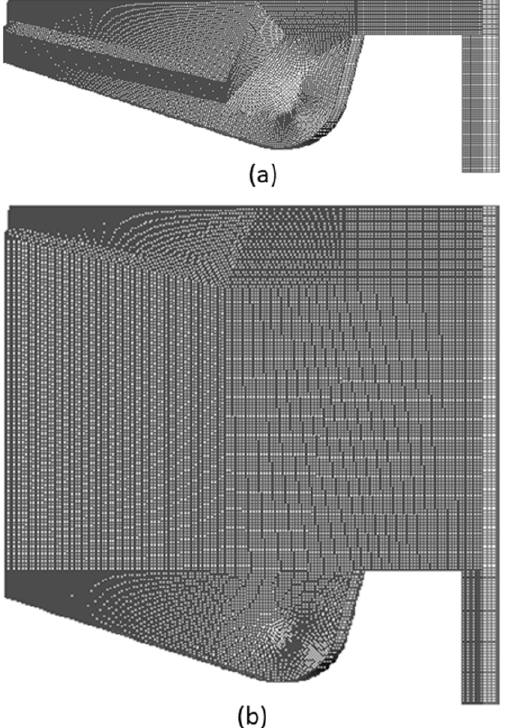
Figure 4. One-twelfth of the entire 3D computational mesh of the combustion chamber at the TDC ( a ) and 60 CAD ATDC ( b